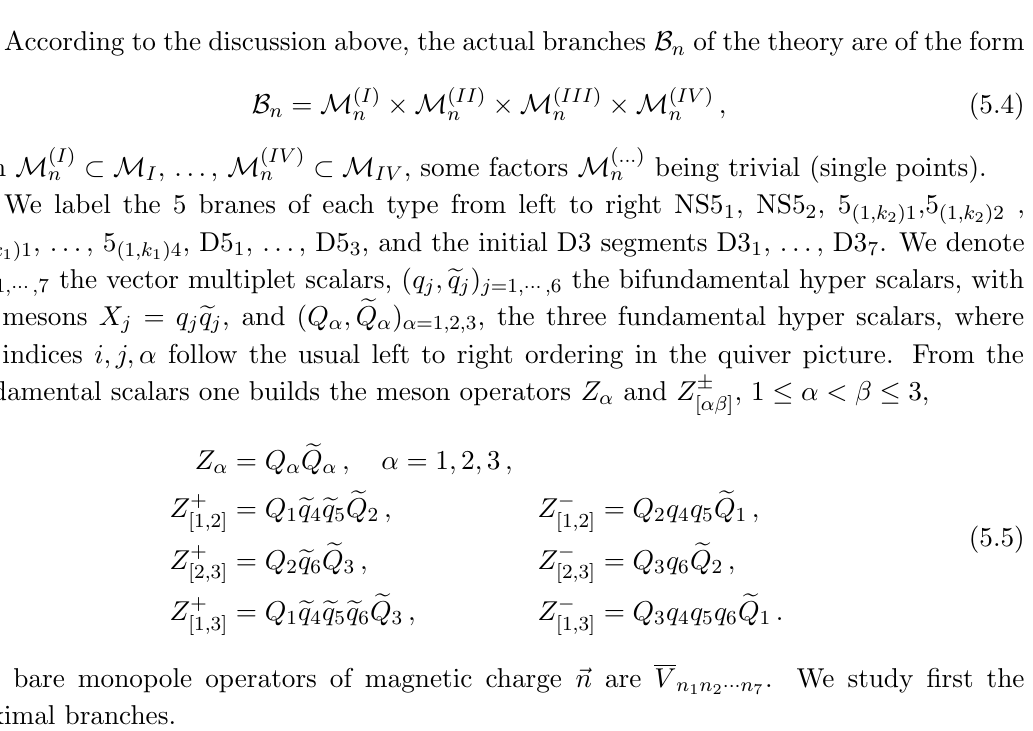
Figure 25 . Quiver and brane realization of the T [4] theory in the x 3 ; 7